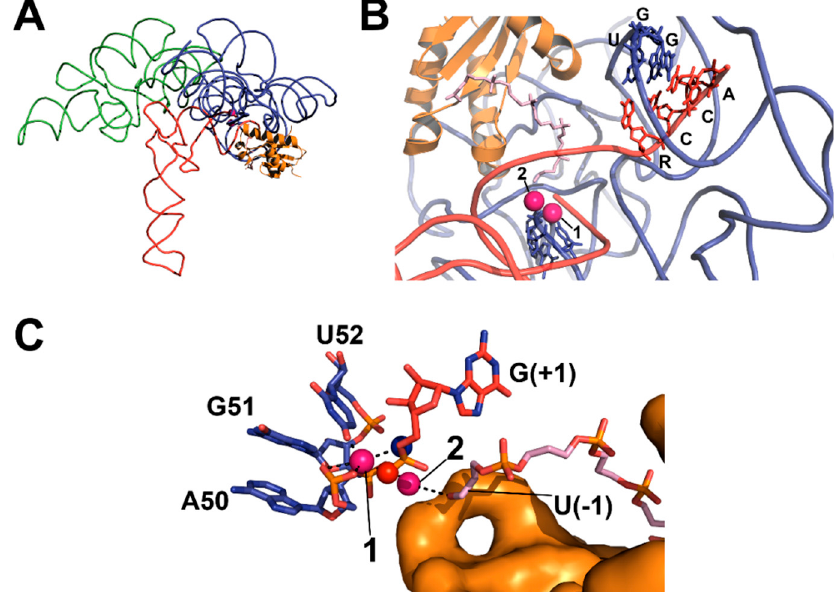
Figure 4. X ‐ ray crystal structure of T . maritima RNase P ‐ tRNA ‐ leader product complex (PDB 3q1r, PyMOL) [22]. ( A ) The holoenzyme ‐ product complex of RNase P is shown, including C ‐ (blue backbone) and S ‐ (green backbone) domains, tRNA (red backbone), and RnpA (orange cartoon); ( B ) Topology of substrate contact sites in the catalytic domain (colored as in A), including the 5’ leader (light pink sticks) bound to RnpA and proposed divalent metal ions (pink spheres). Base ‐ pairing between GGU residues in P RNA and the 3’ RCCA of tRNA (U256–R(73), G255–C(74), G254–C(75)) is shown; ( C ) Topology of the active site (colored as in A), including the active site residues (blue carbon atoms), product G(+1) (red carbon atoms), the 5’ leader (light pink carbon atoms) bound to RnpA (orange surface), proposed metal contacts (black dashed lines), and positions of the pro ‐ R P (red sphere) and pro ‐ S P (blue sphere) oxygens of the product 5’ phosphate.